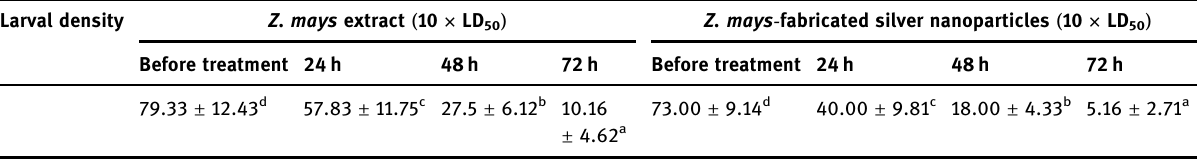
Table 5: Field reduction of Ae. aegypti larval populations post - treatment with Z. mays silk extract and AgNPs in water storage reservoirs Larval